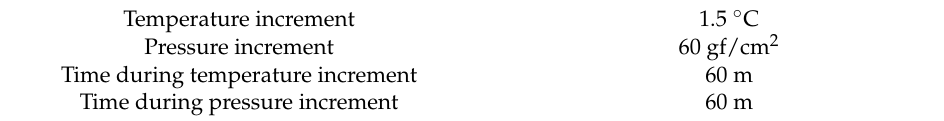
Table 5. Algorithm configuration to detect